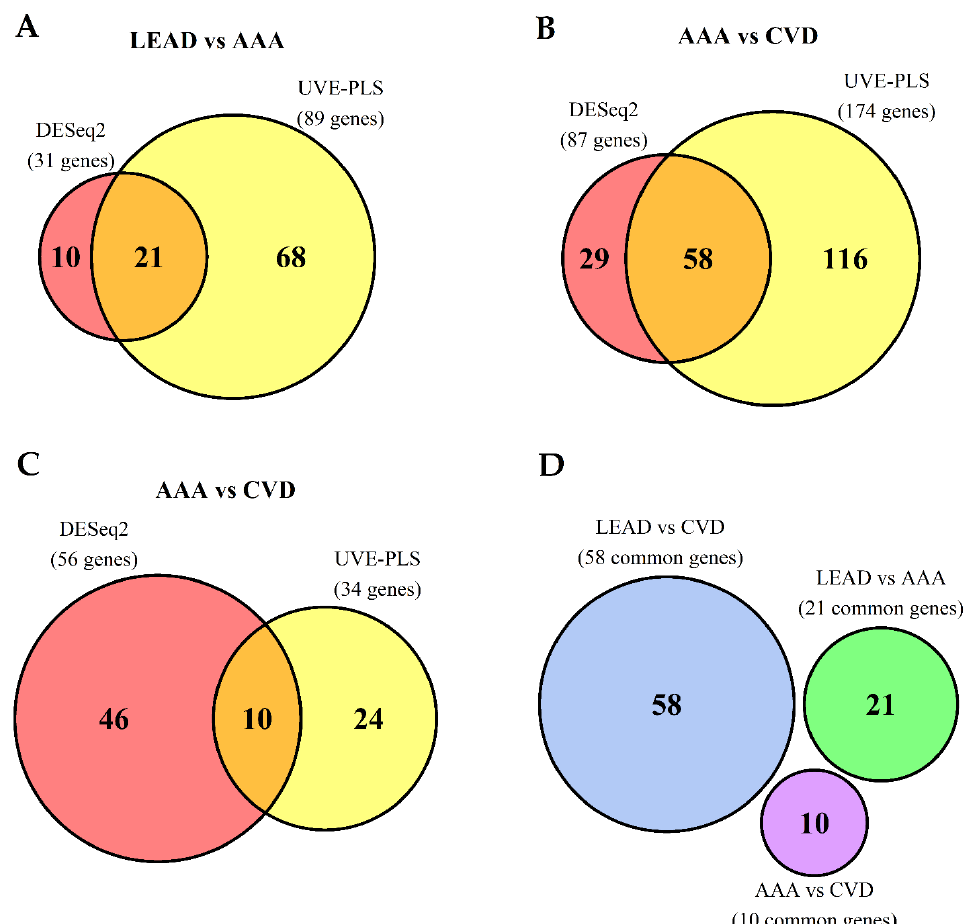
Figure 3. The comparison of differentially expressed genes resulted from comparative analysis performed using DESeq2 and UVE-PLS methods between ( A ) LEAD and AAA groups, ( B ) LEAD and CVD groups as well as ( C ) AAA and CVD groups. Genes were selected using unified selection criteria: p value adjusted by Benjamini–Hochberg false discovery rate <0.001 (for DESeq2 results) and reliability score ≥8 (for UVE-PLS results). The number in the middle fields in each Venn diagram represents the number of genes common for both methods. Genes shared by both methods from each comparison (genes from the middle fields in Venn diagrams on panel A – C ) were selected and compared on the subsequent Venn diagram ( D ), which shows a lack of sharing genes. AAA—abdominal aortic aneurysm, CVD—chronic venous disease, LEAD—lower extremities arterial disease, UVE-PLS—Uninformative Variable Elimination by Partial Least Squares.